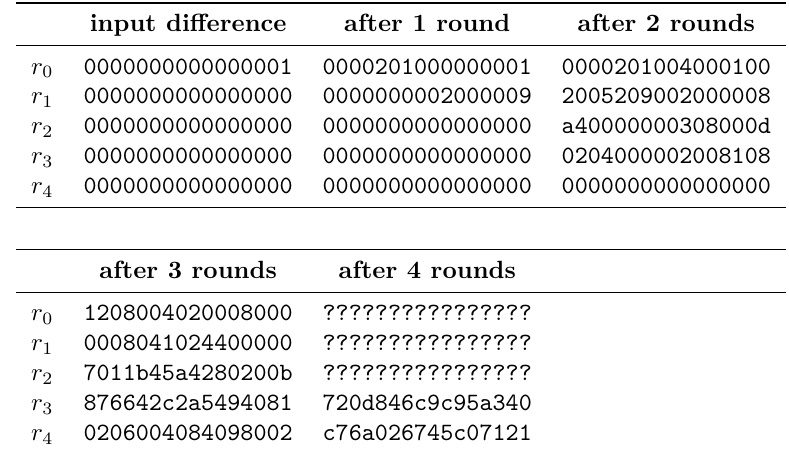
Table 24: Differential characteristic to create forgery for round-reduced Ascon-128 with a 4-round finalization. The differential probability is 2 − 100 . The breakdown of the probability (in − log ) is [2 , 14 , 50 , 34] 2 input difference